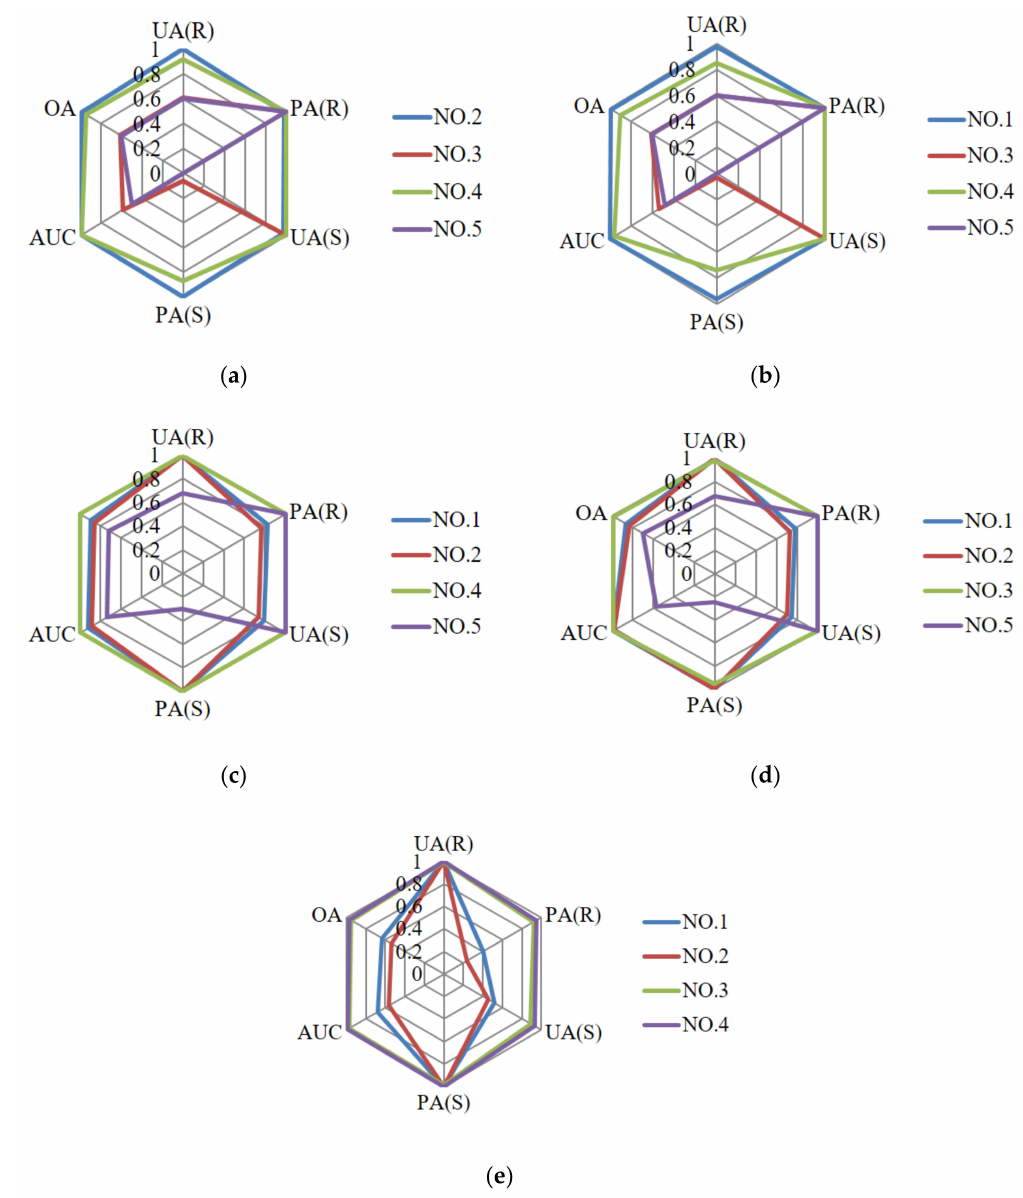
Figure 6. Accuracies of the random forest (RF)-based models using the top five polygon samples to predict each other, where OA, AUC, PA, UA, S, and R represent overall accuracy, the area under the ROC curve, producer’s accuracy, user’s accuracy, landslide source, and runout, respectively. ( a ) No. 1, ( b ) No. 2, ( c ) No. 3, ( d ) No. 4, and ( e ) No. 5 polygon samples for